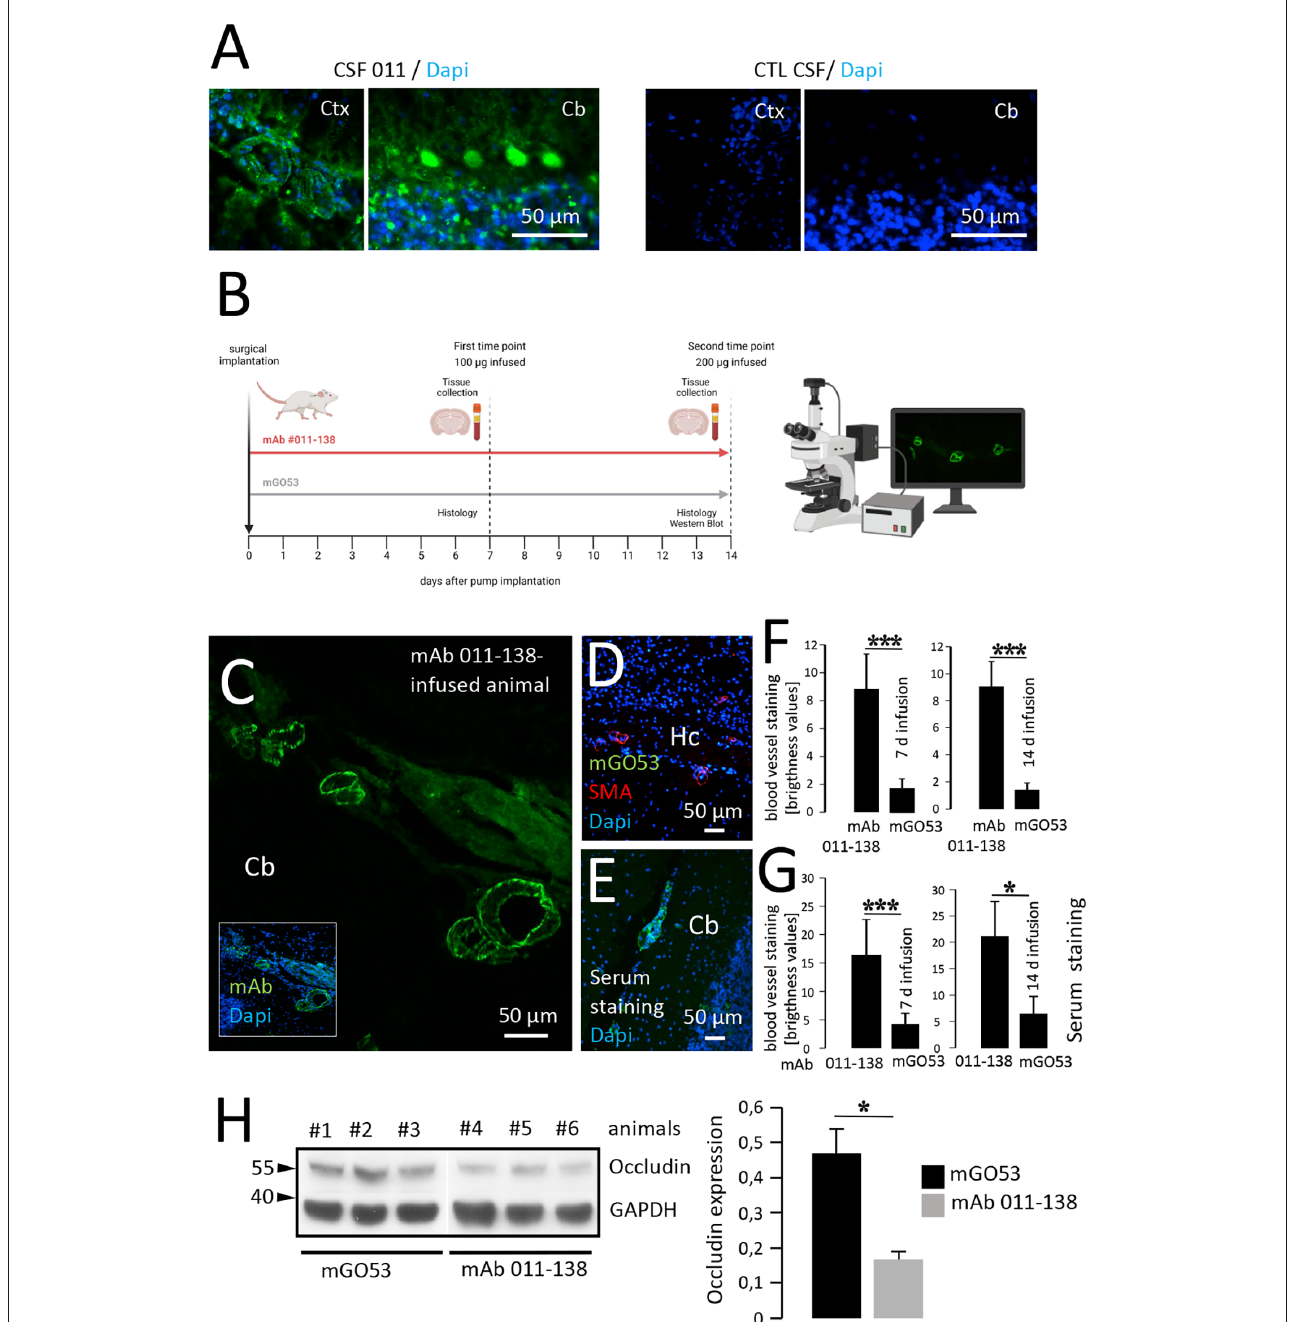
FIGURE4 Intrathecal application of antibody 011-138 leads to in vivo blood vessel binding and Occludin downregulation. (A) Sections from unfixed adult mouse brains were incubated with CSF of patient 011 and an age-matched control patient at a dilution of 1:2. Incubation with 011 CSF resulted in IgG staining of blood vessels and cerebellar Purkinje cells. Incubation with control CSF yielded no staining. (B) Adult mice were either administered a dose of 100 µ g of human monoclonal antibody (mAb) 011-138 into the right lateral ventricle for 7 days or 200 µ g for 14 days. Animals were sacrificed, brains were removed, and immediately frozen for immunohistochemistry. In addition, blood was collected to obtain serum. (C) Representative sagittal brain section from an animal treated for 14 days with mAb 011-138 was incubated with FITC-coupled anti-human IgG. Clear staining of large to mid-size blood vessels in all brain regions was visible (shown for the cerebellum, Cb ). (D) Sagittal brain section from one animal treated with control antibody mGO53 for 14 days. Incubation with a secondary antibody revealed no staining Hc = hippocampus . (E) Sagittal unfixed brain section from an untreated adult mouse was incubated with serum (dilution 1:200) from an animal that had received mAb 011-138 for 14 days. Visualization with secondary antibody revealed staining of larger to mid-size blood vessels by the mouse serum. (F) Quantification of blood vessel IgG immunoreactivity. Data are given as means ± SEM from three animals per condition. Per condition,between 38 and 43 blood vessel sections were analyzed. *** p ≤ 0.001. (G) Quantification of serum blood vessel IgG immunoreactivity on naive brain sections. Data are given as means ± SEM from three animals per condition. Per condition, between 22 and 45 blood vessel sections were analyzed. * p ≤ 0.05, *** p ≤ 0.001. Brightness levels of mGO53 staining were within the background range. (H) Downregulation of Occludin by mAb 011-138. In brains of mice treated with mAb 011-138 for 14 days protein expression was strongly reduced by 65% compared to animals that had received mGO53. Data are given as means ± SEM adjusted to loading from seven animals per condition from two independent experiments. * p ≤ 0.05. Three animals per condition from one experiment are exemplarily